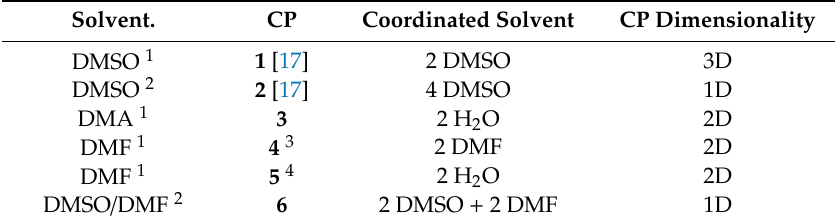
Table 2. The e ff ect of coordinating solvents towards the final Cu–bpy based CPs.